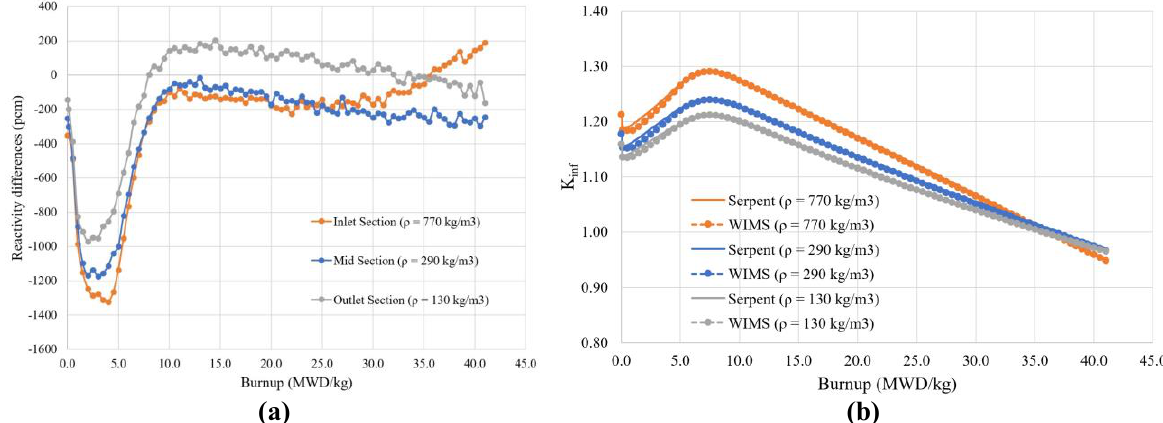
Figure 2. Benchmark 2D-Assembly Level of WIMS vs Serpent: (a) Reactivity Differences; (b) k- infinity.